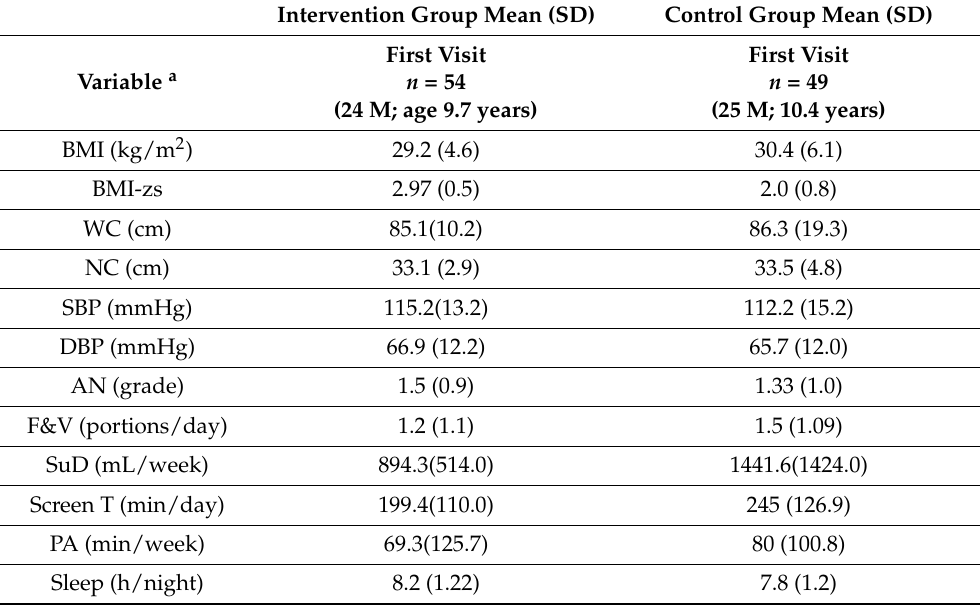
Table 1. Clinical parameters of the 103 patients allocated to Intervention and Control Groups of PediaFit 1.1 + PediaFit 1.2. at entry.